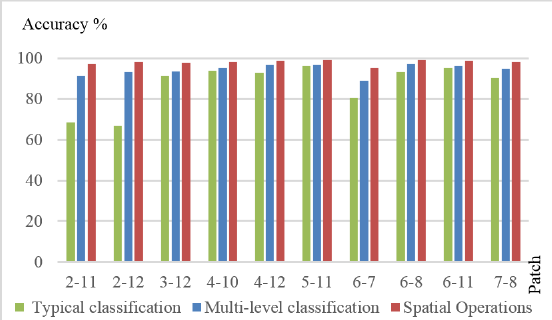
Figure 15. Building accuracy of the proposed method in test patches.